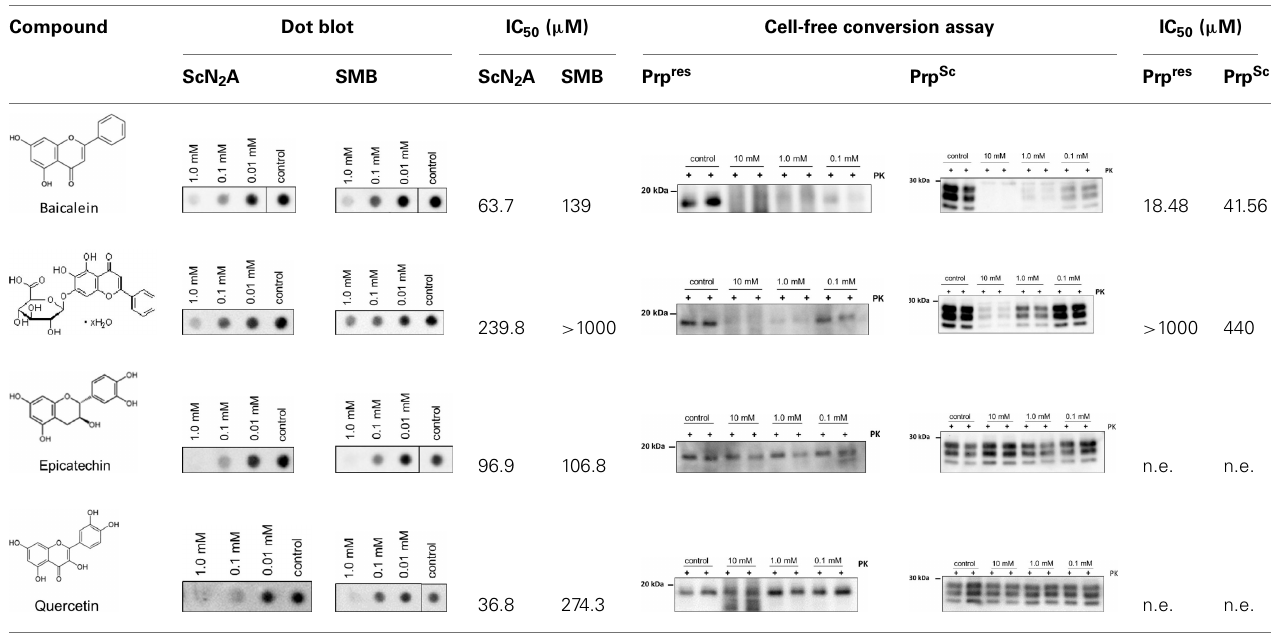
extract.Western blot was analyzed by standard chemiluminescence method. + : incubation with proteinase K (PK).